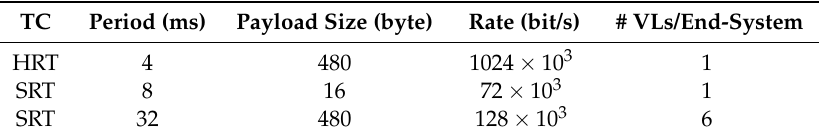
Table 5. Traffic Classes.